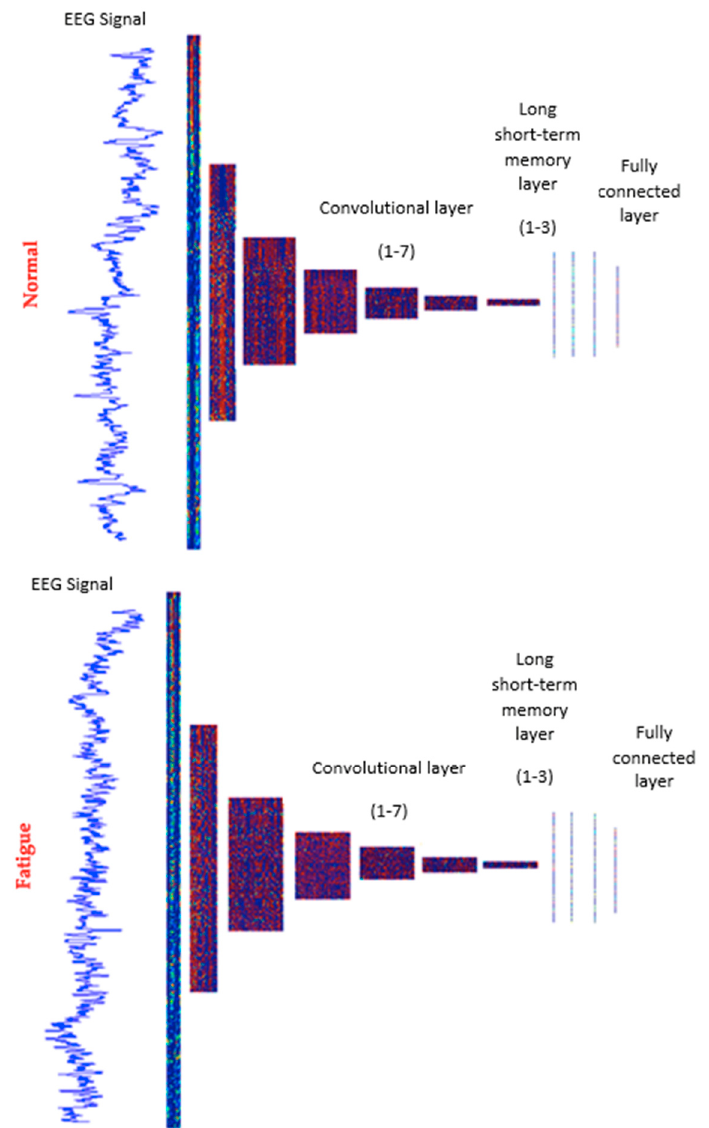
Figure 17. Visualization of convolutional, long short-term memory, and fully connected layers in the proposed deep network for a sample of normal and fatigue states.